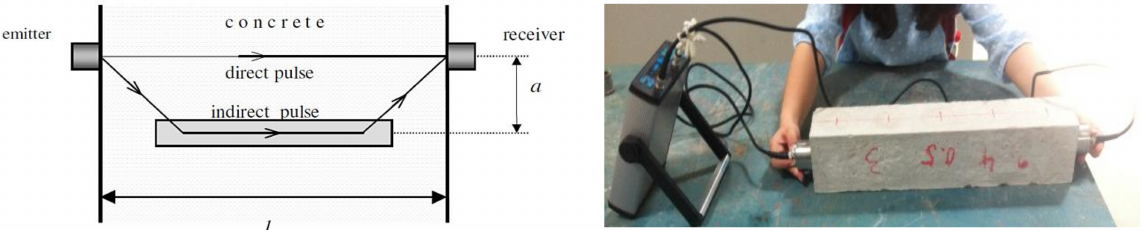
Figure 7. Direct test in reinforced concrete.